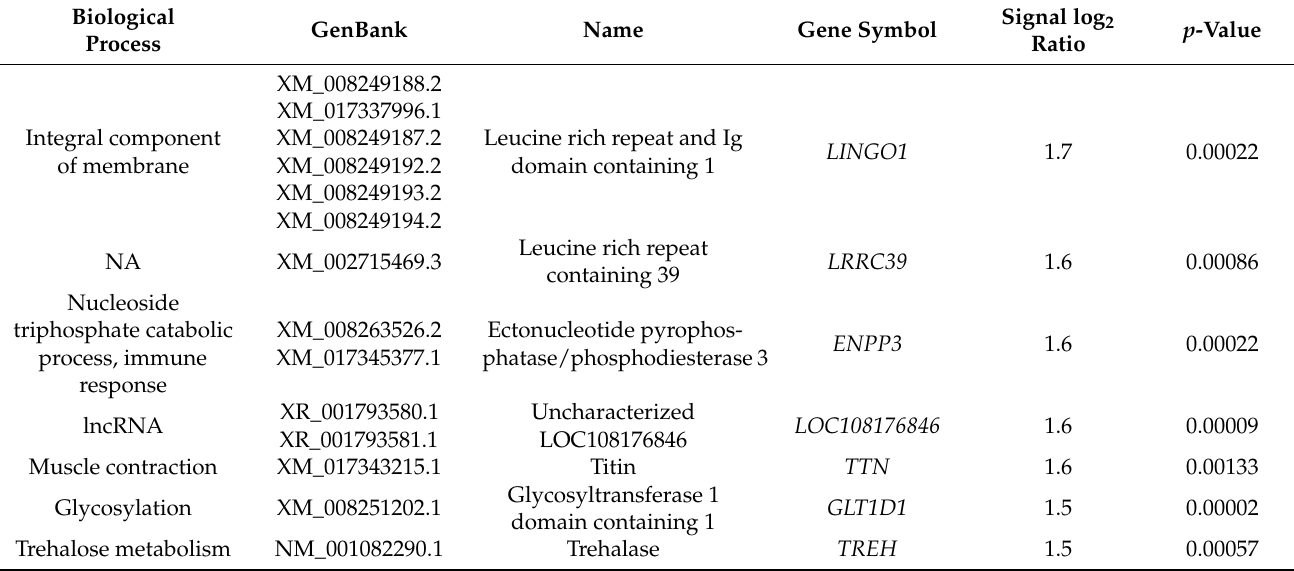
Figure 6. Network of hepatic transcripts. A, Association among transcript changes assayed by RT- qPCR. Red, up regulation. Blue, down regulation. Significant Spearman ’ s correlations ( p < 0.02). Likewise, significant associations were observed among several transcripts and the hepatic content of metabolites in cholesterol biosynthetic pathways, including lanosterol, dihydrolanosterol, and desmosterol (Figure 7A). In this regard, down regulations of